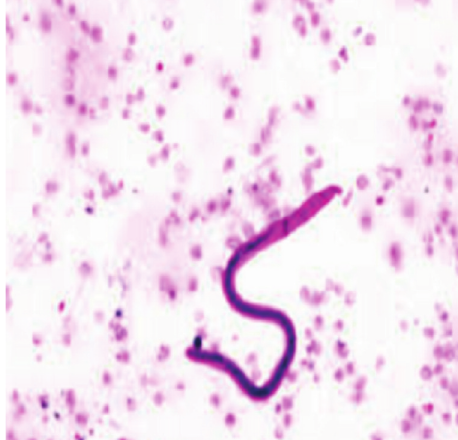
Cytological smear showing W. bancrofti (Giemsa stain Fig. 2: with 100X oil